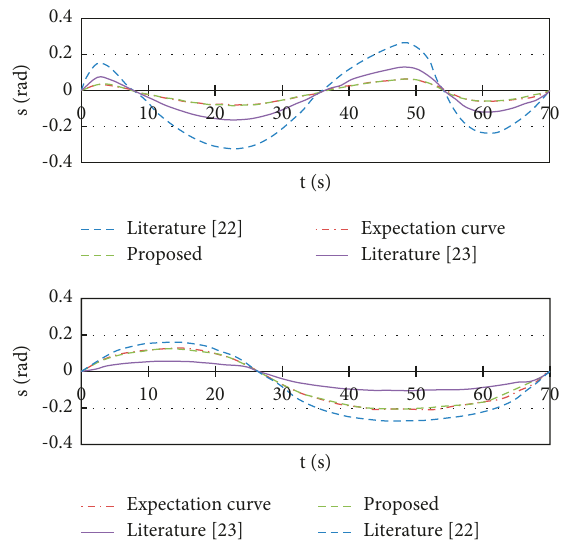
Figure 4: Joint 1 and joint 2 curves of